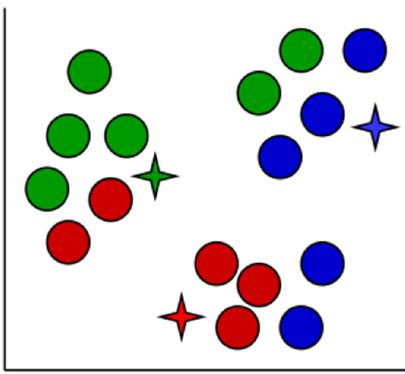
Figure 7. Step 4— K -means: K = 3 Step 4: Data point added to its nearest cluster.